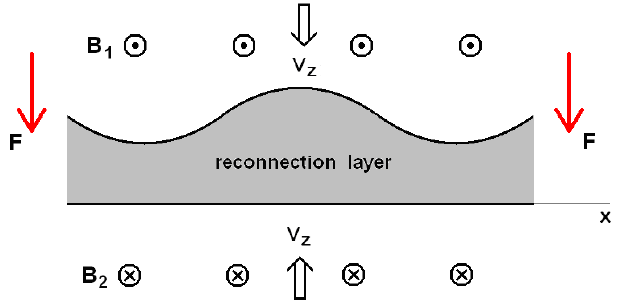
Figure 3. A schematic for finding the growth rate of R-T instability. Region 1 is related to a Fig. 3. A schematic for finding the growth rate of R–T instability. Figure 2. Generation of interchange instability on upper boundary of the diffusion region Fig. 2. Generation of interchange instability on upper boundary of Region 1 is related to a heavier fluid, region 2 to a lighter fluid. heavier fluid, Region 2 to a lighter fluid. The undisturbed boundary between two fluids is located the diffusion region surrounding the reconnection layer in the pres- The undisturbed boundary between two fluids is located in the x-y surrounding the reconnection layer in the presence of a force F, normal to the layer. B and B ence of a force F , normal to the layer. B 1 and B 2 are the magnetic plane (normal to the figure plane). The gravitational acceleration g 1 2 in the x-y plane (normal to the figure plane). The gravitational acceleration g is downward. M is fields above and below the reconnection layer. V z is the initial ve- is downward. M is the mass of a fluid element having the height locity of plasma with a frozen-in magnetic field. The violated upper are the magnetic fields above and below the reconnection layer. V is the initial velocity of equal to 1 /k where k is the wave the mass of a fluid element having the height equal to 1/ k where k is the wave number. z boundary shows an interchange disturbance. plasma with a frozen-in magnetic field. The violated upper boundary shows an interchange disturbance. comes either lighter or heavier than ambient plasma. If